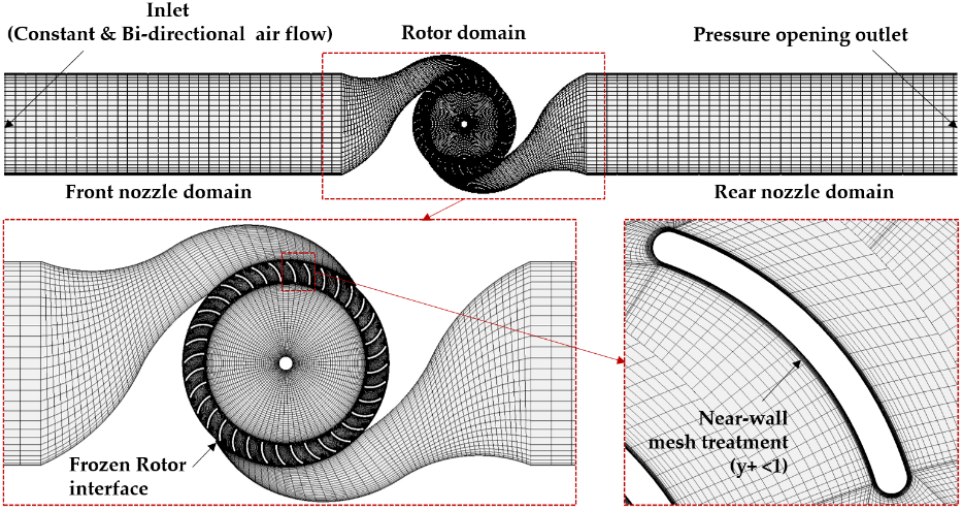
Figure 2. The grid and boundary condition of the numerical turbine model.